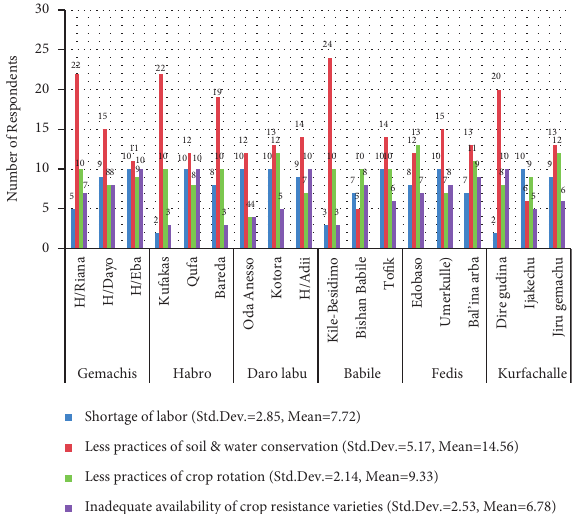
Figure 5: Growers opinion on factors hindering Striga